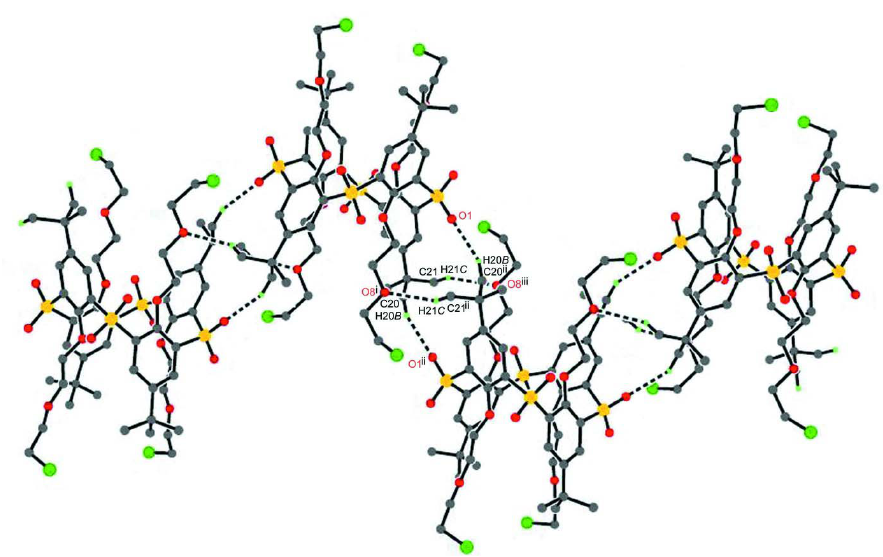
Figure 4 The hydrogen-bonded zigzag one-dimensional chains of the title molecule with R 22 (13), R 22 (16), R 22 (21) and R 22 (26) motifs. The minor disordered moieties and some hydrogen atoms are omitted for clarity. [Symmetry codes: (i) - x + 1, y , - z + 3/2; (ii) - x + 1, - y + 1, - z + 1; (iii) x , - y + 1, z - 1/2]. 5,11,17,23-Tetra- tert